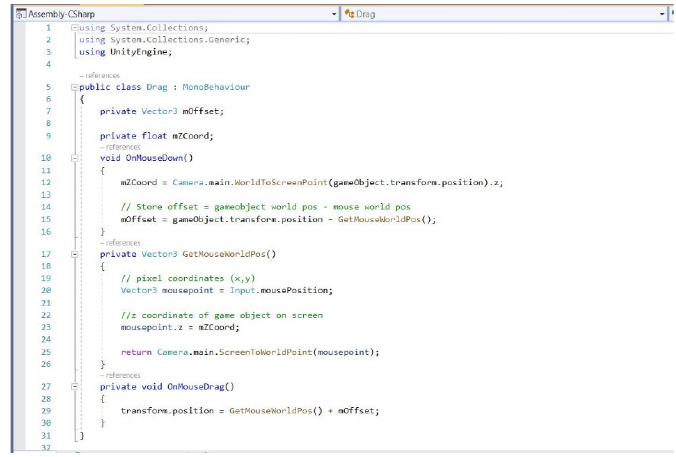
Fig. 4. C# Sharp script for grabbing and moving objects in visual